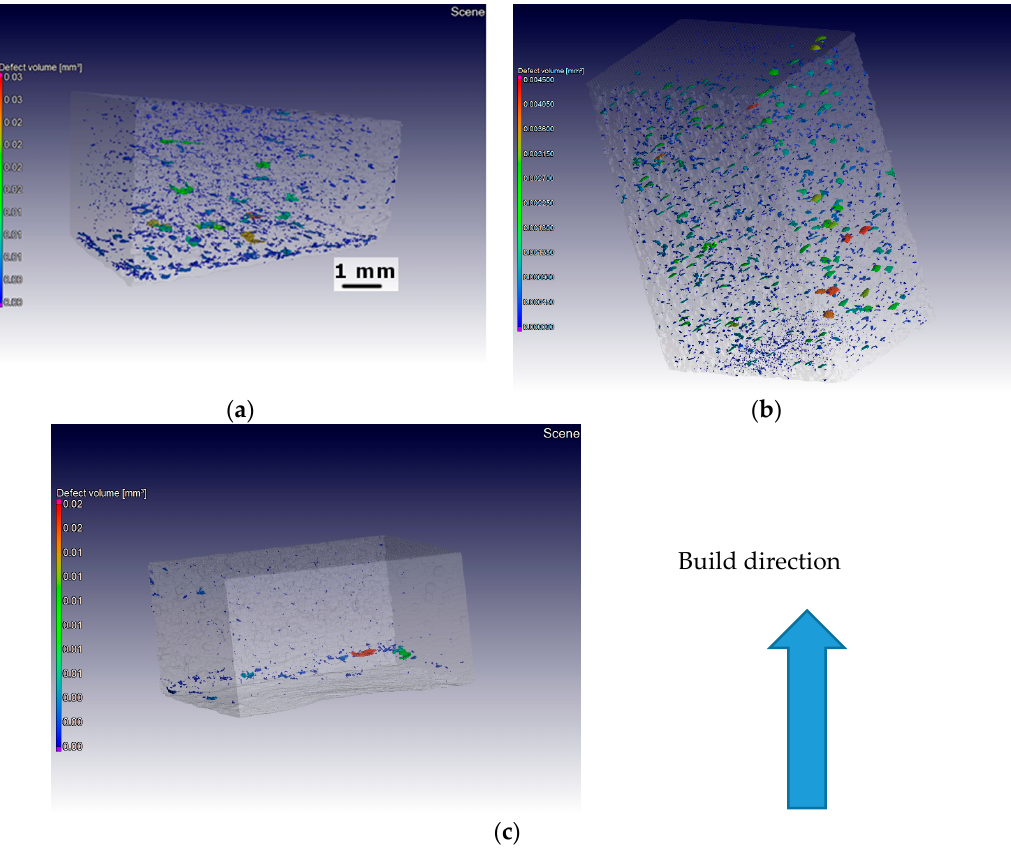
Figure 11. Micro-computed tomography (micro-CT) representation of pores/imperfections in γ -TiAl samples produced using low ( a ); medium ( b ); and high ( c ) energy input samples.